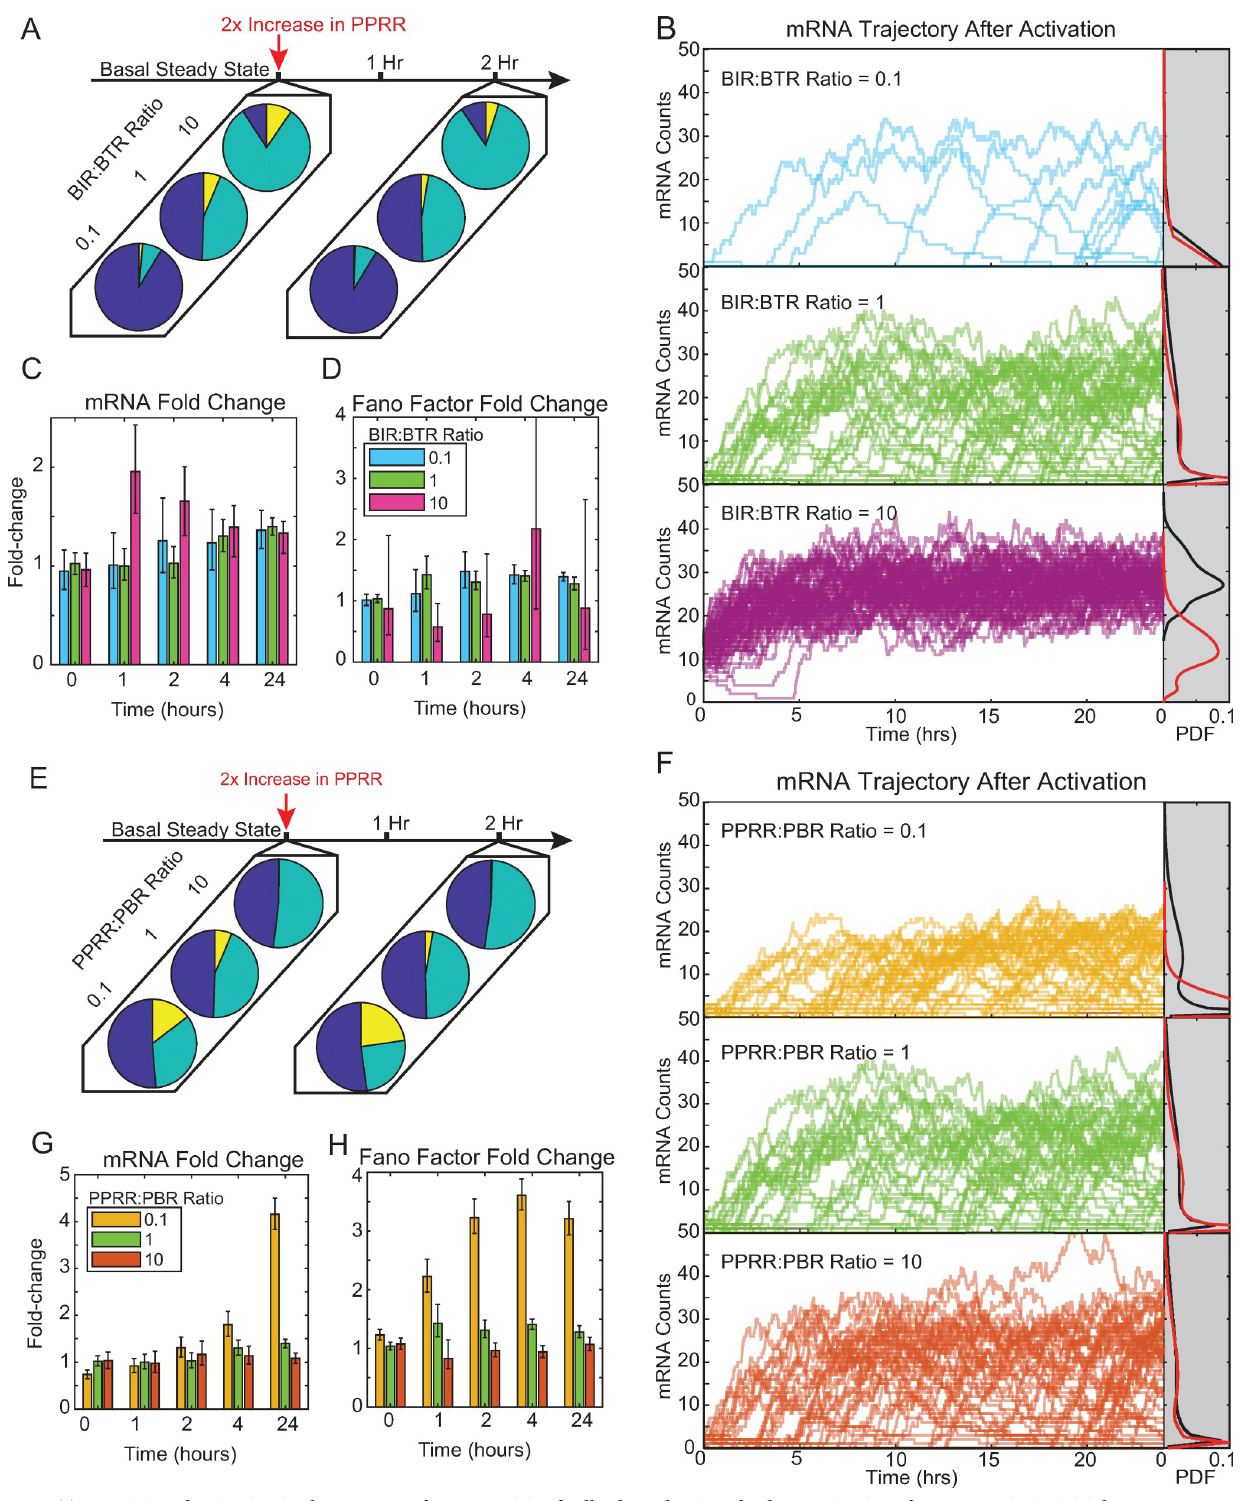
Fig 4. Transcriptional activation in the presence of PPRR positive feedback predominately alters activation of more permissive initial promoter states. (A) Three representative fractional promoter-state probability pie charts with the addition of feedback of UP (blue), AP (teal) and BP (yellow) for BIR:BTR ratios of 0.1, 1, and 10 with PBR and PPRR held constant at 10 hr -1 . Data presented as described in Fig 2A. (B) Representative simulated trajectories with feedback for BIR:BTR = 10 (pink), BIR:BTR = 1 (green), and BIR:BTR = 0.1 (cerulean) presented as described in (Fig 2B). Gray regions on